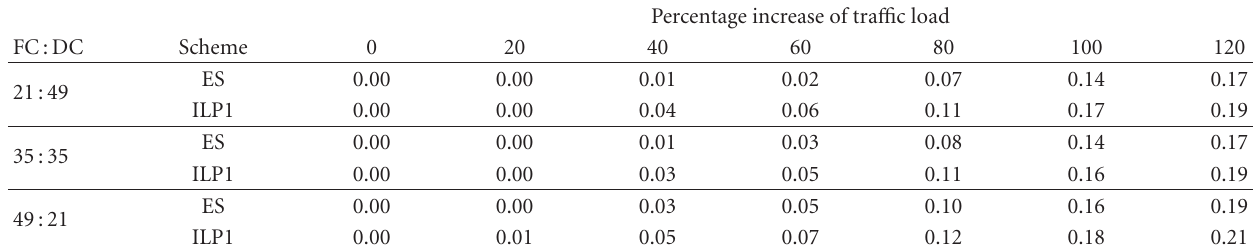
Table 2: Performances of ILP1 and the ES approach proposed in [6].